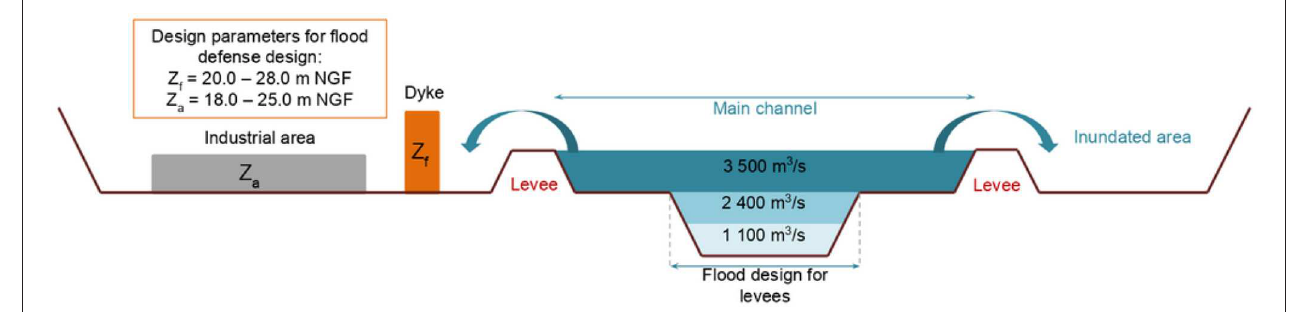
FIGURE 2 | Typical cross-section of the Garonne between Tonneins and La Réole and the design zone. In gray, the industrial area (slab elevation Z a ), in orange, the wall to be designed (elevation Z f ).